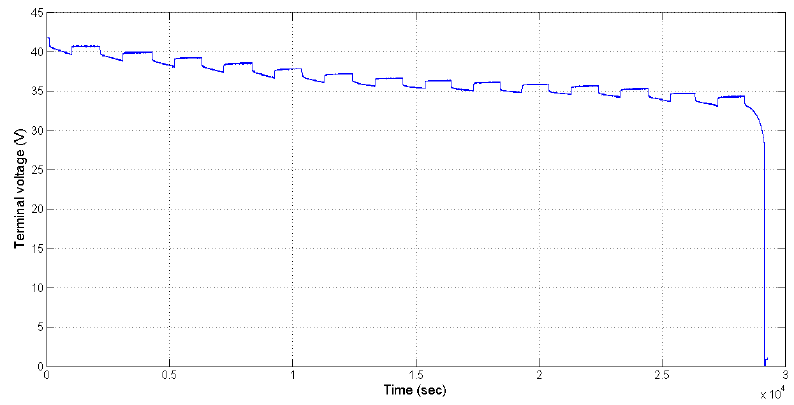
Figure 5. The measured voltage via Arduino mega 2560.